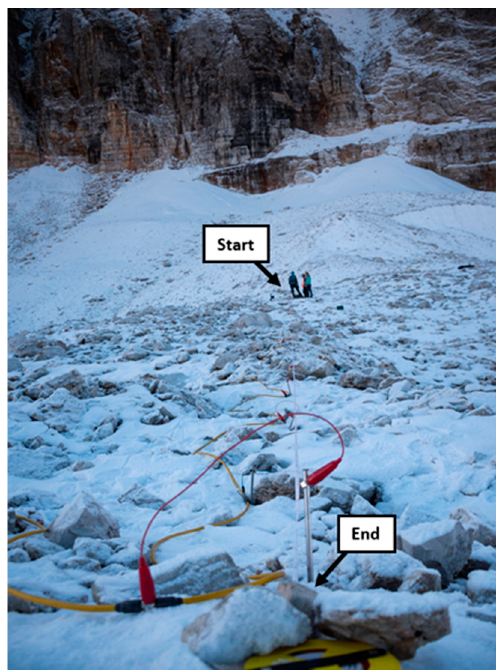
Figure 2. Picture taken during the electrical resistivity tomography (ERT) measurements performed on the Murfreit rock glacier in July 2020. “Start” is the position of the first electrode and “end” is the position of the last electrodes. The line of 70.5 m is composed of 48 electrodes spaced 1.5 m apart. Table 1. ERT survey acquisition parameters .